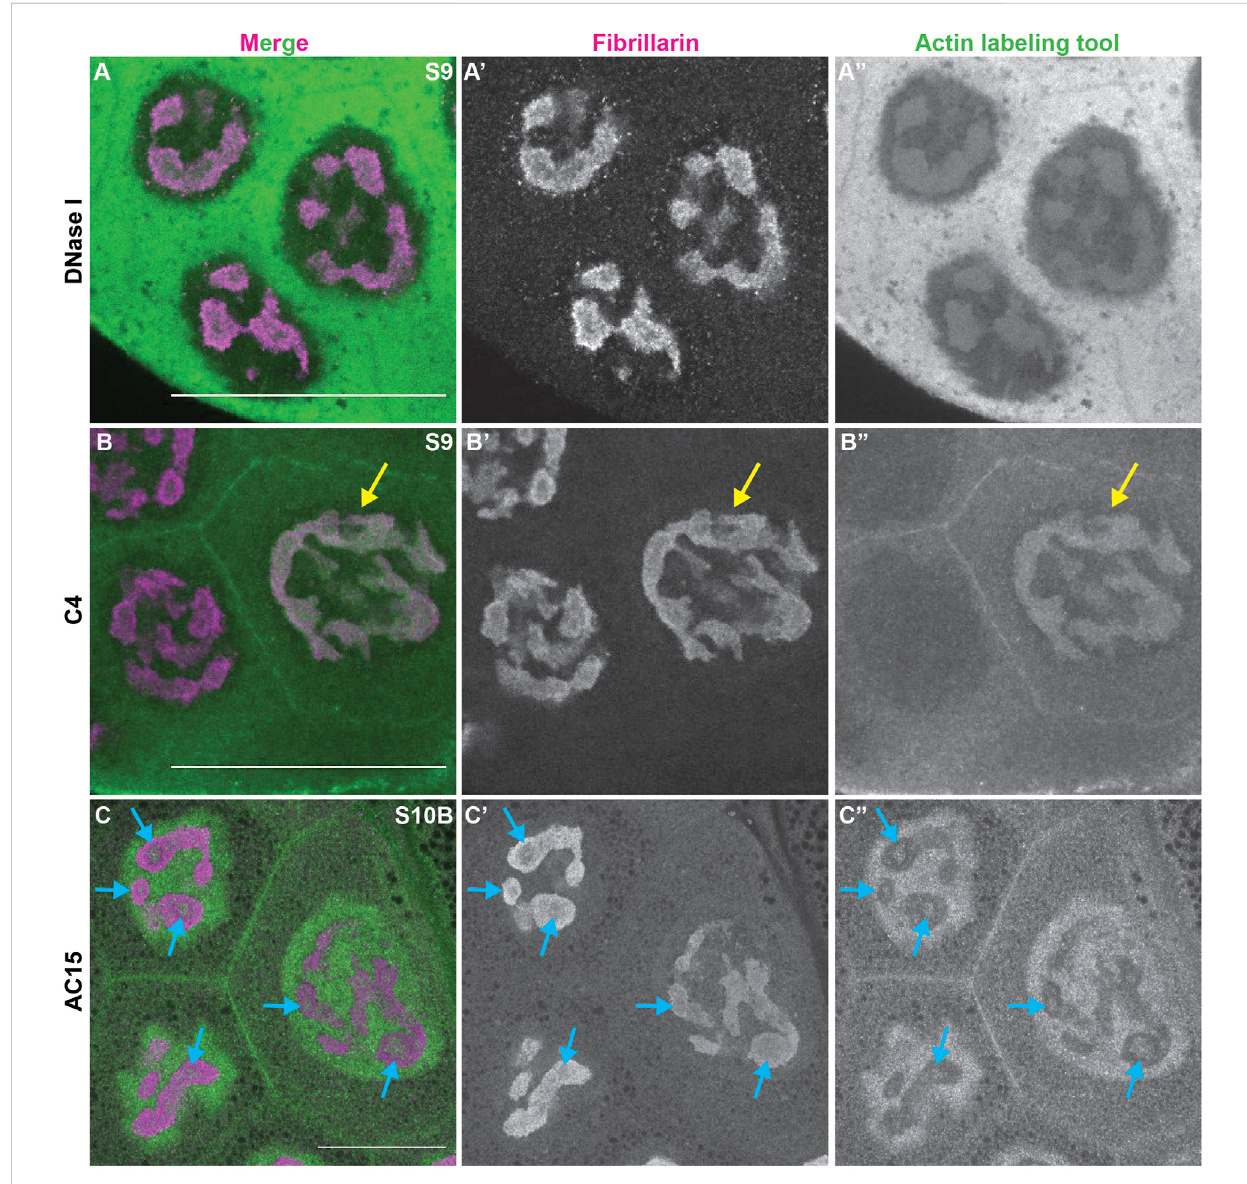
FIGURE 3 Nuclearactinisenrichedinthenucleolus. (A-C ” ) .Maximumprojectionsof2-5confocal slicesofzoomedinregionsofafewnursecellsofwild-type folliclesoftheindicatedstages(S)stainedforthenucleolus(Fibrillarin,magentainmerge)andthreedifferentnuclearactinlabelingtools(greeninmerge): DNaseI (A-A ” ) ,anti-actinC4 (C4, (B-B ” ) ),and anti-actin AC15(AC15, (C-C ” ) );scale bars=50 μ m.Yellow arrowindicatesaC4 positive nucleolusand blue arrowsindicateAC15positivenucleolarpuncta.DNaseI,whichlabelsallmonomericactin,isenrichedthroughoutthenucleolusofeverycell (A-A ” ) ), whereas C4 labels whole nucleoli of a subset of nurse cells (yellow arrow, (B-B ” )). AC15 nuclear actin is largely localized to the chromatin, but in mid- oogenesis it labels puncta within every nurse cell nucleoli (C-C ” ) , blue